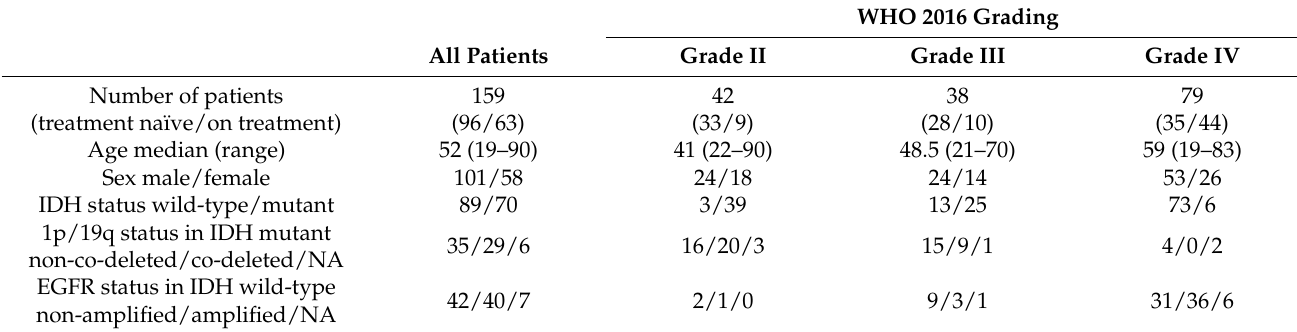
Table 1. Patient